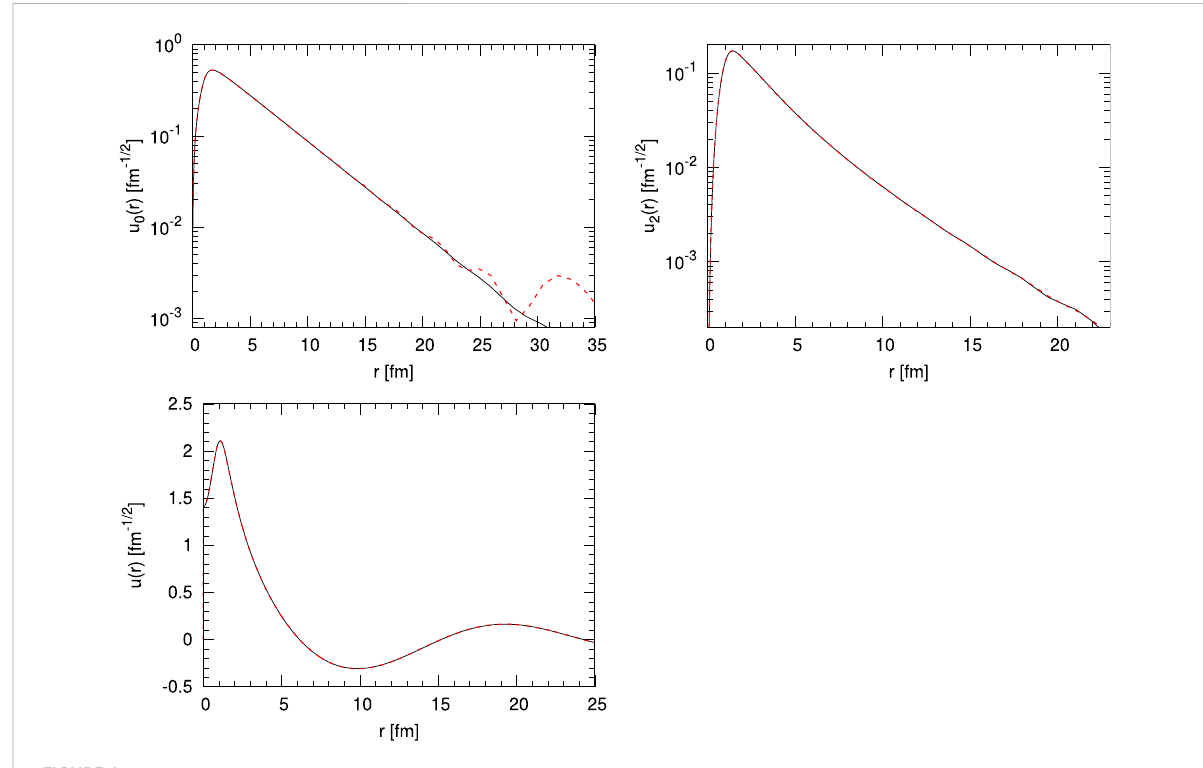
FIGURE 1 Deuteron u 0 ( r ) (left top panel) and u 2 ( r ) (right top panel) functions, and the nn 1 S 0 function (left bottom panel) at E =5 MeV are calculated with the variational (dashed red line) and the Numerov (black solid line) methods. The NVIa potential is used. To appreciate the differences between the two methods, the function u 0 ( r ) and u 2 ( r ) are shown in a semilogarithmic